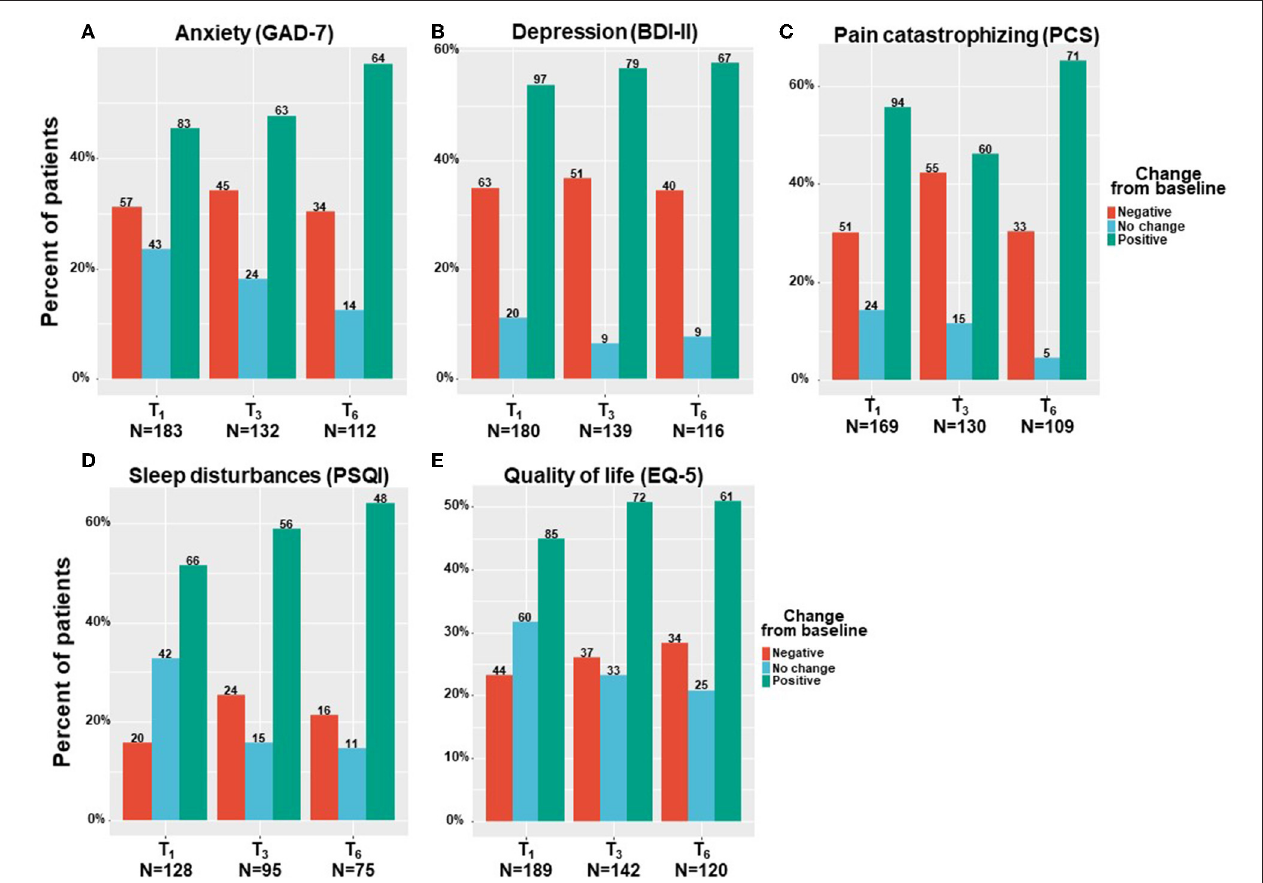
FIGURE 5 | Cancer comorbid symptoms change from baseline. T 1 , 6-month Follow-Up; T 3 , 6-month Follow-Up; T 6 , 6-month Follow-Up: GAD-7, general anxiety disorder; BDI, Beck depression inventory; PCS, pain catastrophizing scale; PSQI, Pittsburgh sleep quality index; EQ-5, Euro-QoL questionnaire; Negative indicates patients that reported on higher comorbid symptoms at a follow-up compared to baseline; Positive indicate patients that reported on lower comorbid symptoms at a follow-up compared to baseline; No change indicate patients that reported on the same comorbid symptoms at a follow-up compared to baseline; Numbers of patients are based on patients that reported fully on the measures at baseline and at the corresponding follow-up time